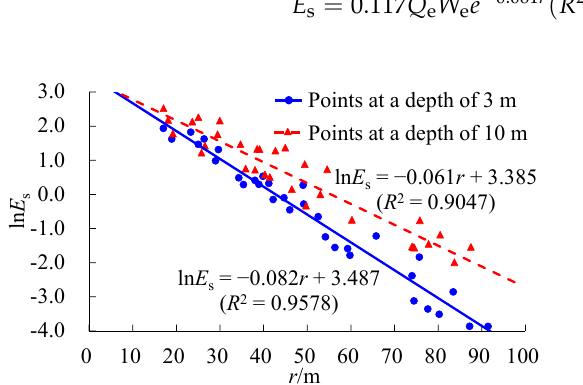
Figure 13. Regression analysis of seismic energy attenuation with distance along the monitoring points at different depths.